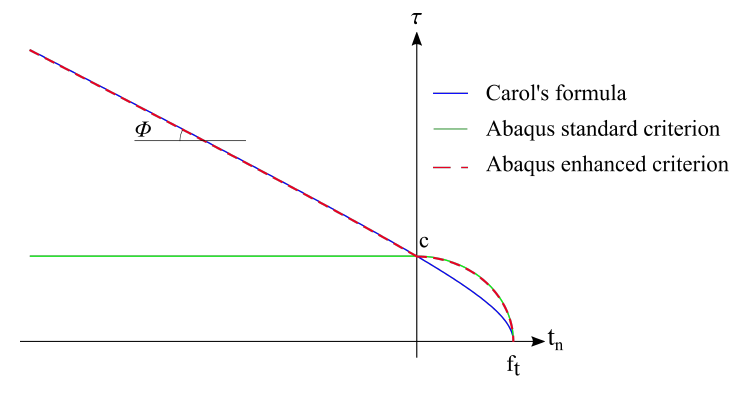
Figure 5. Failure envelopes for a concrete-to-concrete